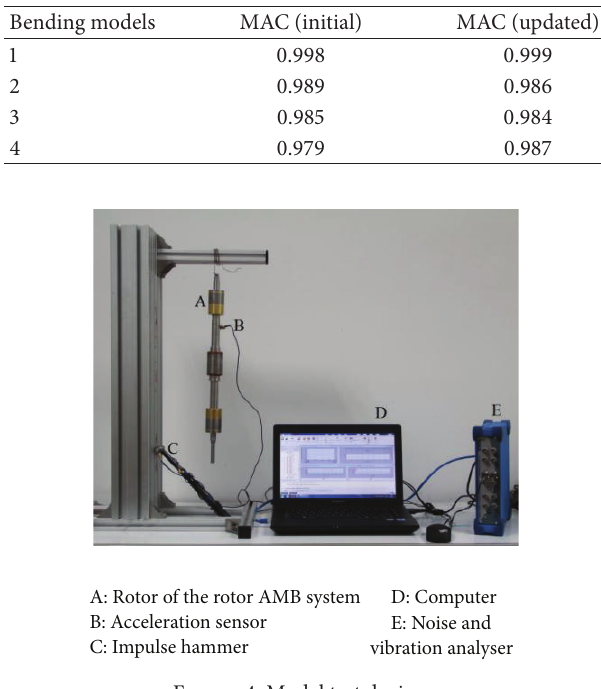
Table 3: Comparison for MAC value.